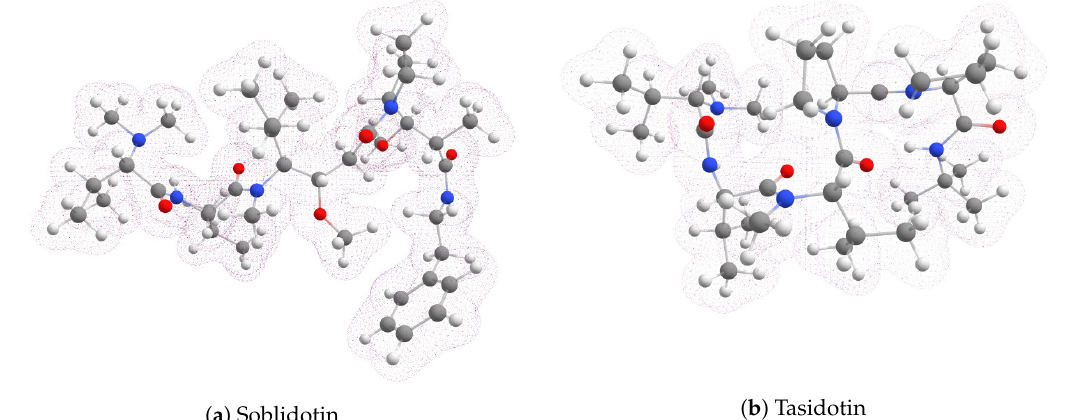
Figure 2. Graphical sketches of the total electronic densities of the anticancer marine peptides: ( a ) Soblidotin and ( b )